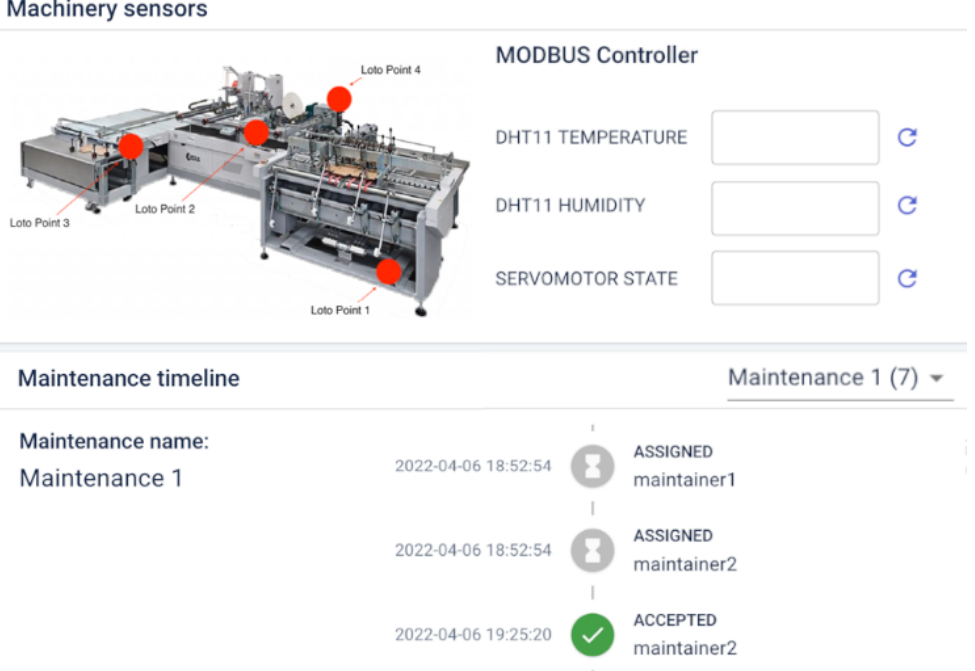
Figure 4. Screenshot of the dashboard exposed by the Backend